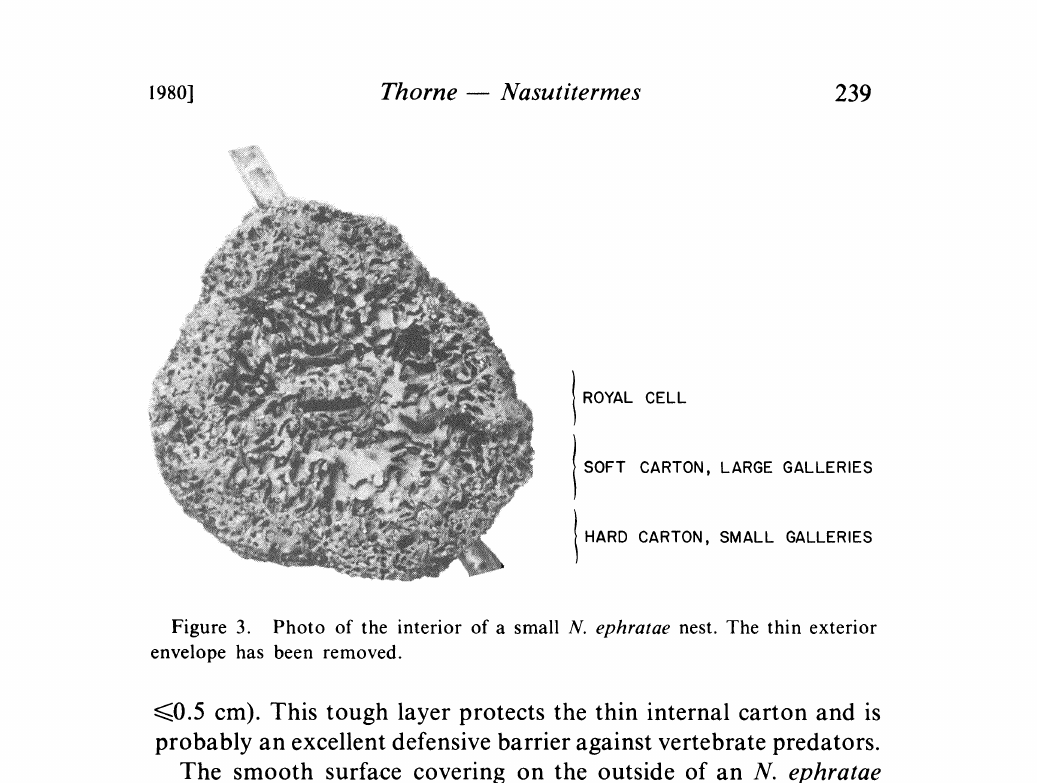
Figure 3. Photo of the interior of a small N. ephratae nest. The thin exterior envelope has been